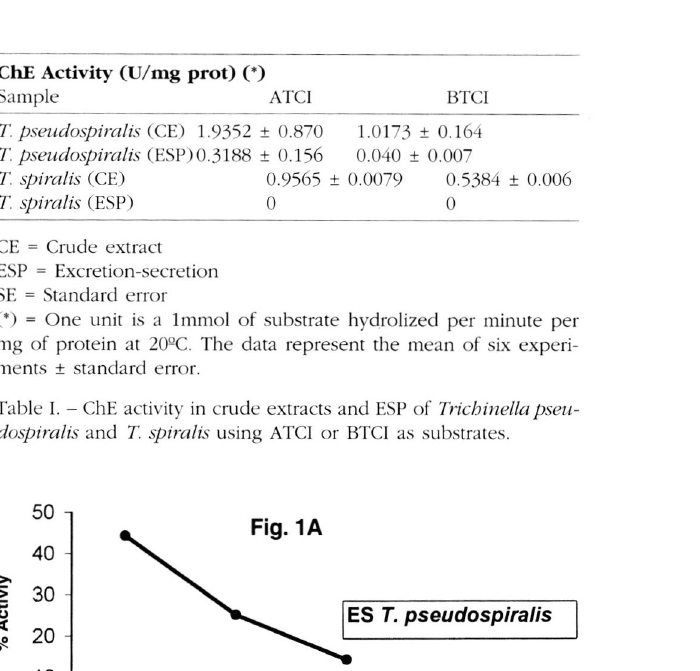
Table I. - ChE activity in crude extracts and ESP of Trichinella pseu dospiralis and T . spiralis using ATCI or BTCI as substrates.